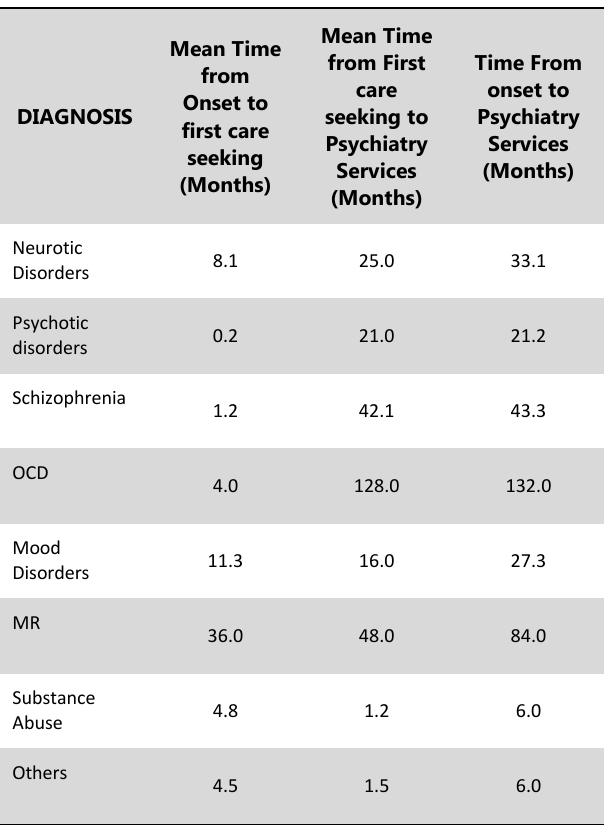
Table . Time Delay in Healthcare Seeking by Psychiatric